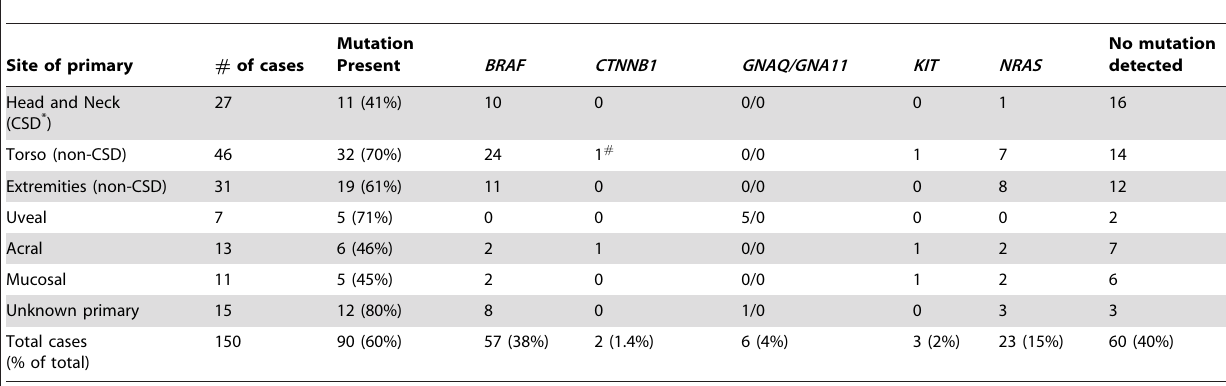
Table 3. Spectrum of mutations in the first 150 melanomas genotyped in the molecular diagnostic